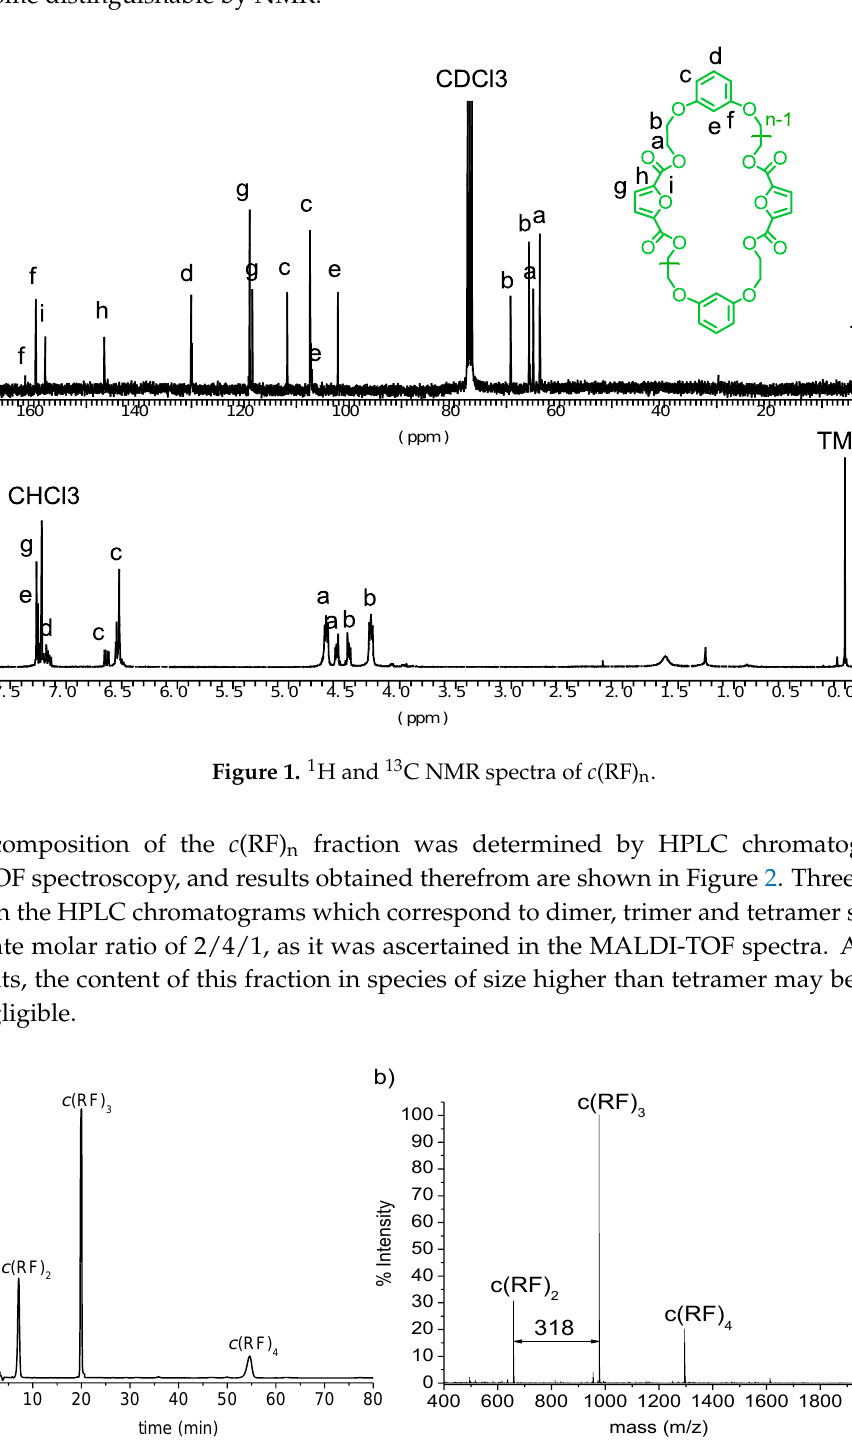
Figure 2. HPLC ( a ) and MALDI-TOF ( b ) of c (RF) n .